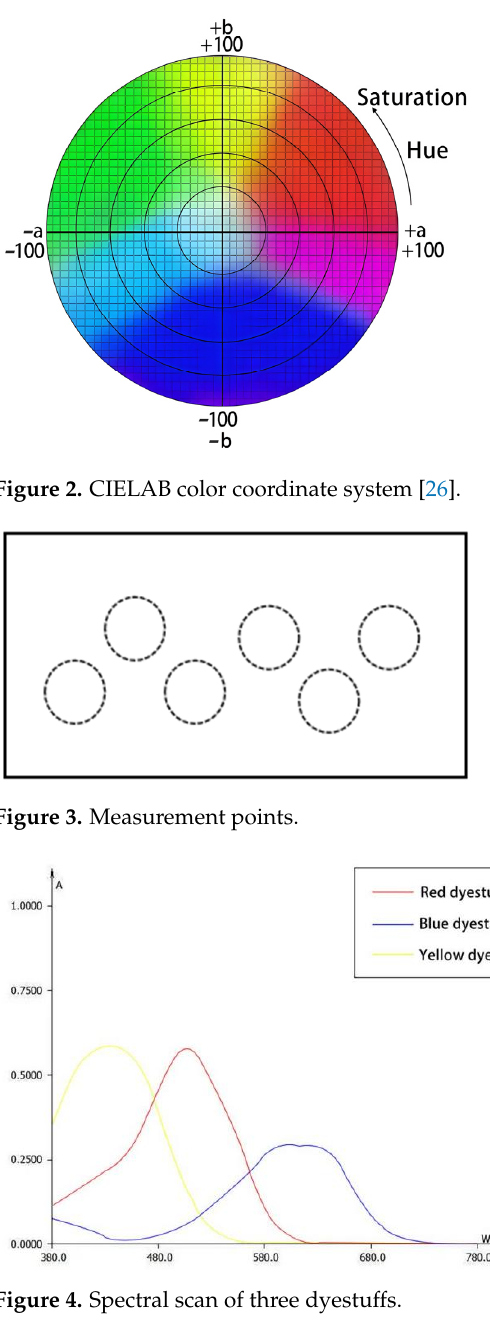
Figure 4. Spectral scan of three dyestuffs.